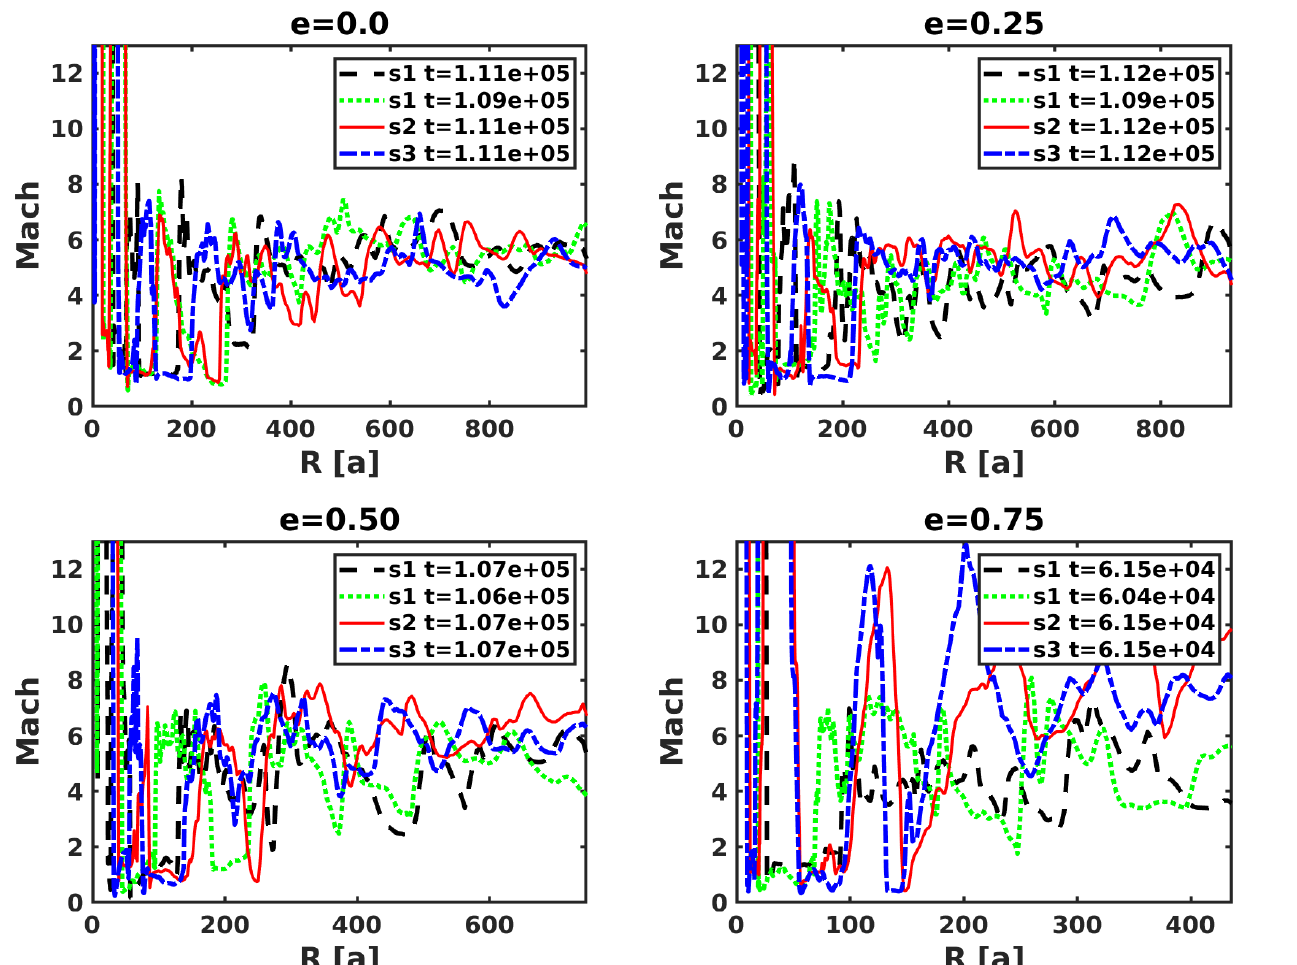
Figure 6. The same as in Figure 4 but for Mach